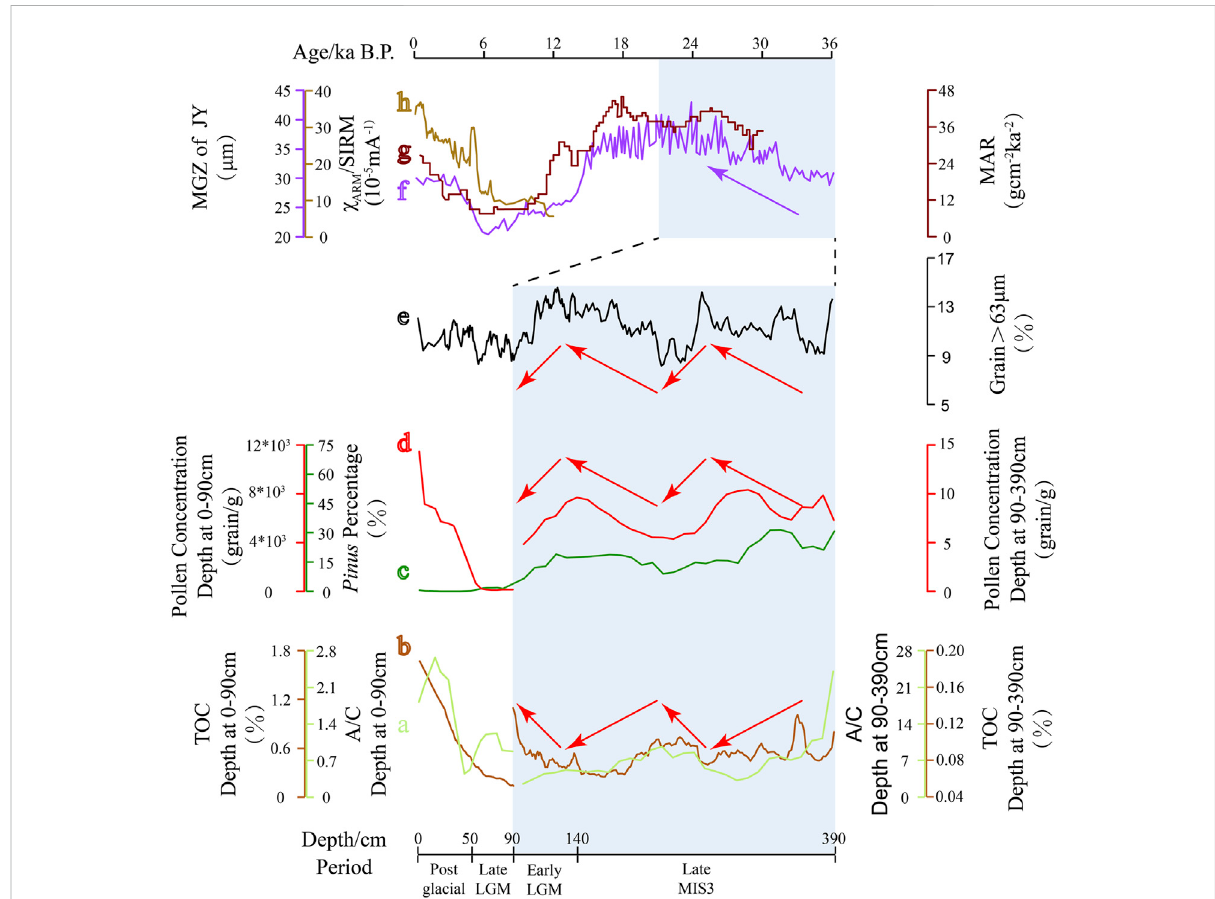
FIGURE 4 Comparison records of pollen assemblages, dust activity, and climate between JRT and ACA during the last 36 ka. (A – E): The smoothed curve obtainedbytheadjacencyaveragingmethodofTOC,A/C,pollenconcentration(Boundedbyadepthof90 cm,thesethreeproxieshavesigni fi cantly different values in the sediment. Thus, they were separated in the graph and set separately on the y-axis), the percentage of Pinus and sand fraction content of the JRT (this study). (F): Mean grain sizes of the Jingyuan loess section located in the northwestern China Loess Plateau (Sun et al., 2010); (G) :stacked mass accumulation rate (MAR) record in the Ilivalley (Kang etal., 2022); (H) :the χ ARM /SIRMratio of the LJW10 Holocene paleosol section (Chen et al., 2016); The red arrows mark the trend of the climate proxies in the JRT section; The purple arrow marks the enhancing trend of Siberian High-pressure from Late MIS3 to LGM; The two blue bars represent the same time period, which is de fi ned by the intensity of the stronger Siberian